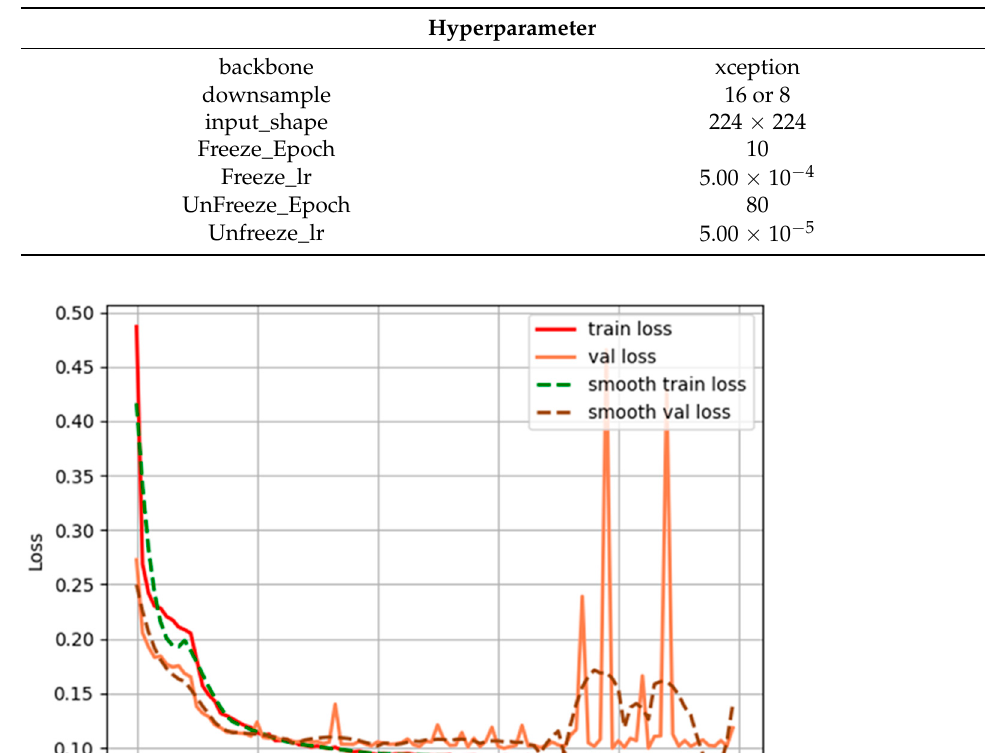
Table 1. Hyperparameters for Deeplab-V3plus.